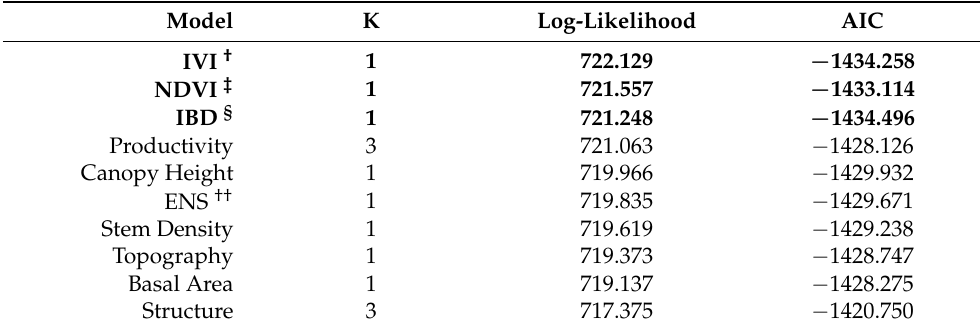
Table 6. Results for within-site gravity model predictions. Rows shown in bold indicate the best supported model based on log-likelihood criteria and corroborated using